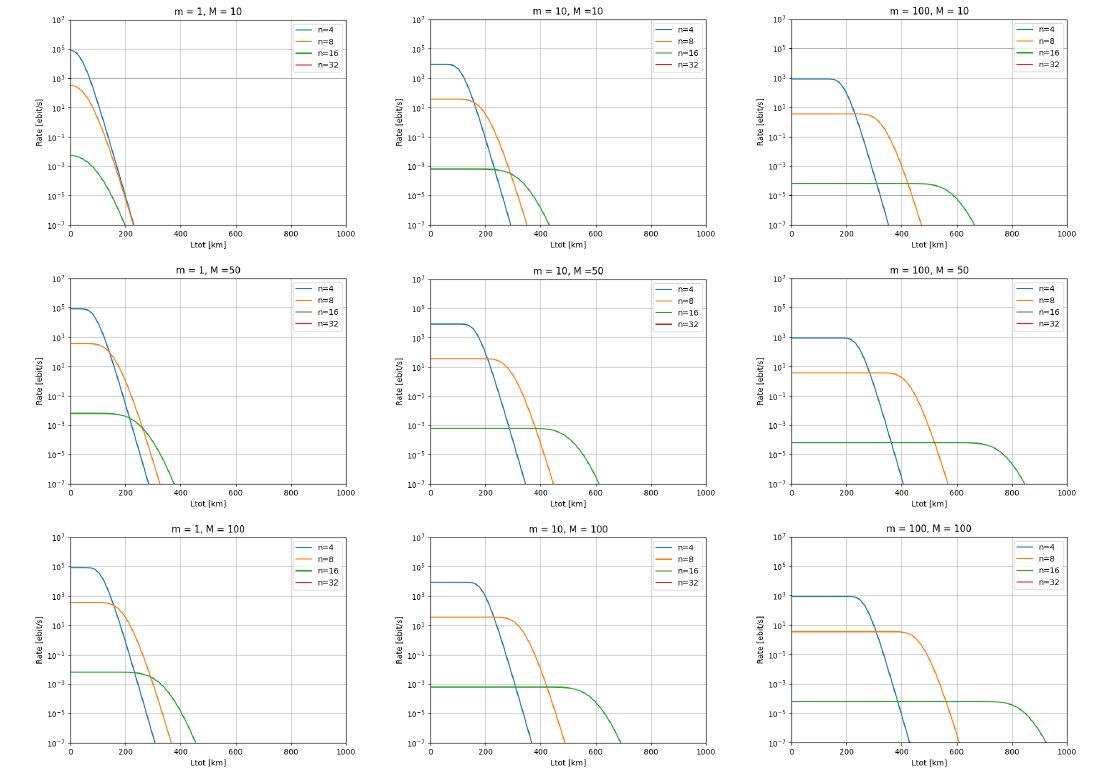
Figure 3. Capacity of a QR chain with simultaneous BSMs, using M parallel channels, and a time- multiplexing block length m . Here, we assume α = 0.15 dB/km, τ = 50 ns, µ = 0.405, and q =